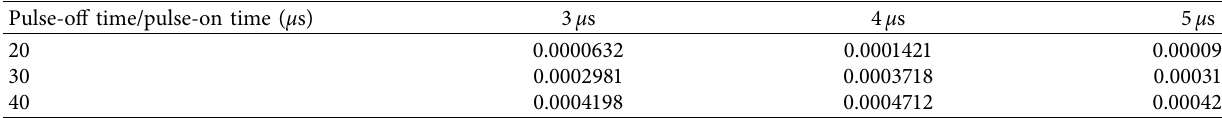
Table 19: MRR at different levels of pulse-on time.